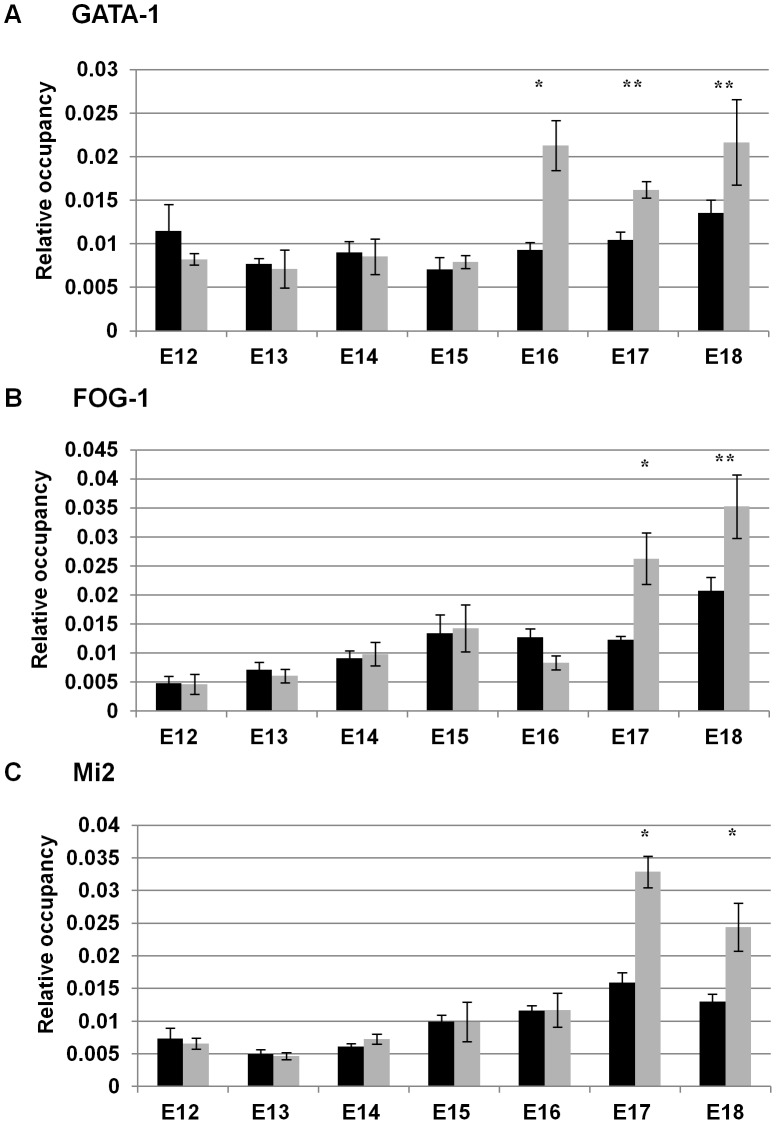
Temporal recruitment of the GATA-1-FOG1-Mi2 complex to the −566 Aγ-globin GATA motif in wild-type β-YAC.ChIP analysis of the −566 Aγ-globin GATA site in fetal liver samples from post-conception days E12–E18 wild-type β-YAC transgenic conceptuses. The relative occupancy of the −566 region of the Aγ-globin gene (GenBank coordinates 38772–38937 from accession file GI455025) by GATA-1, FOG-1, and Mi2 proteins (grey bars) is shown in comparison to IgG control samples (black bars). ChIP was carried out using isotype-matched immunoglobulin (IgG), GATA-1, FOG-1 and Mi2 antibodies (Santa Cruz Biotechnology, Santa Cruz, CA) as described in Materials and Methods. The results are the average of at least two experiments and each experiment was performed in duplicate (* indicates P<0.05 and ** P<0.01). A) GATA-1 protein occupancy; B) FOG-1 protein occupancy; C) Mi2 protein occupancy.